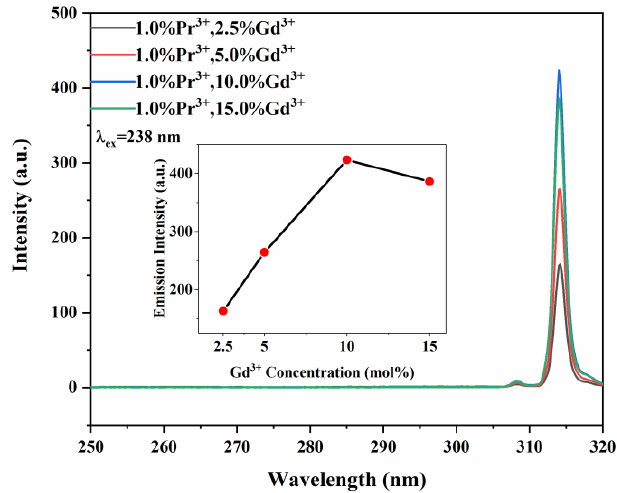
Figure 5. Emission spectra (λ ex = 238 nm) of Y 7 O 6 F 9 :1.0%Pr 3+ , xGd 3+ (x = 2.5%, 5%, 10%, 15%) phosphors.